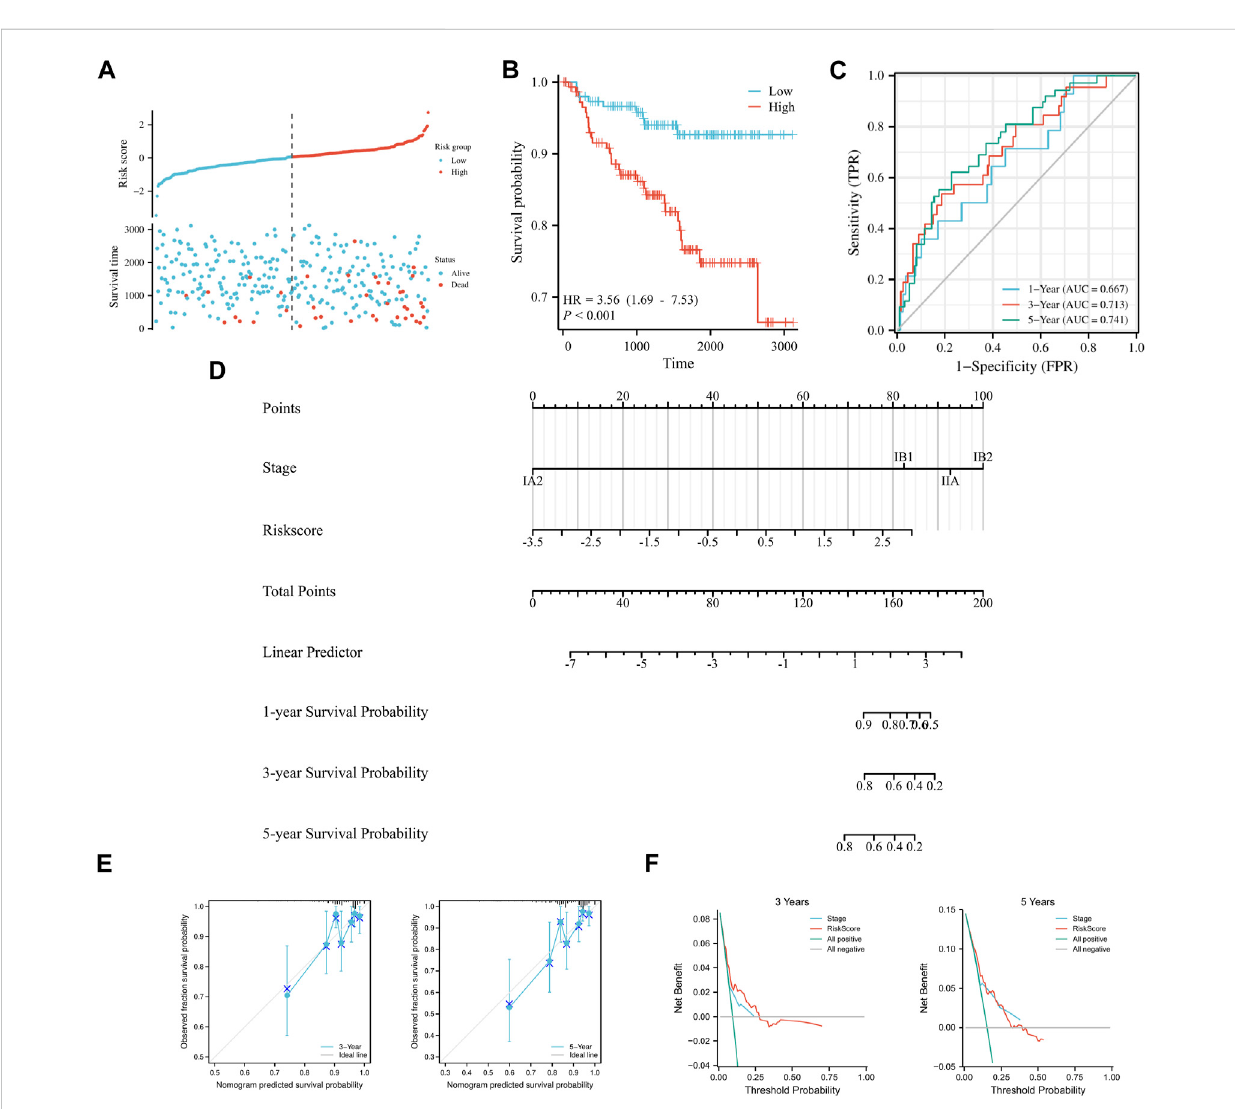
FIGURE 3 Validation of a prognostic model of FRGs in cervical cancer. (A) Curve scatter plot of validation set survival model ef fi cacy assessment and cumulative scatter plot of survival mortality event risk. (B) KM curve shows that there is a signi fi cant difference in OS between high-risk and low-risk groupsinGSE44001. (C) Time-dependentROCcurveswereusedtopredict1,3,and5 yearssurvival. (D) 1,3,and5 yearsnomogramsforpredictingOSin cervical cancer. (E) Calibration curves showing the agreement between predicted and observed 3 and 5 years OS. (F) Decision curve analysis of the prognostic model in the validation set at 3 and 5 years.